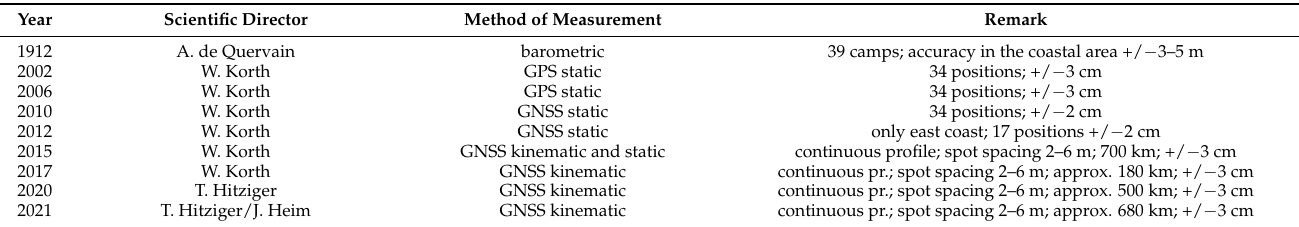
Table 1. Overview of geoscientific Expeditions on the historic